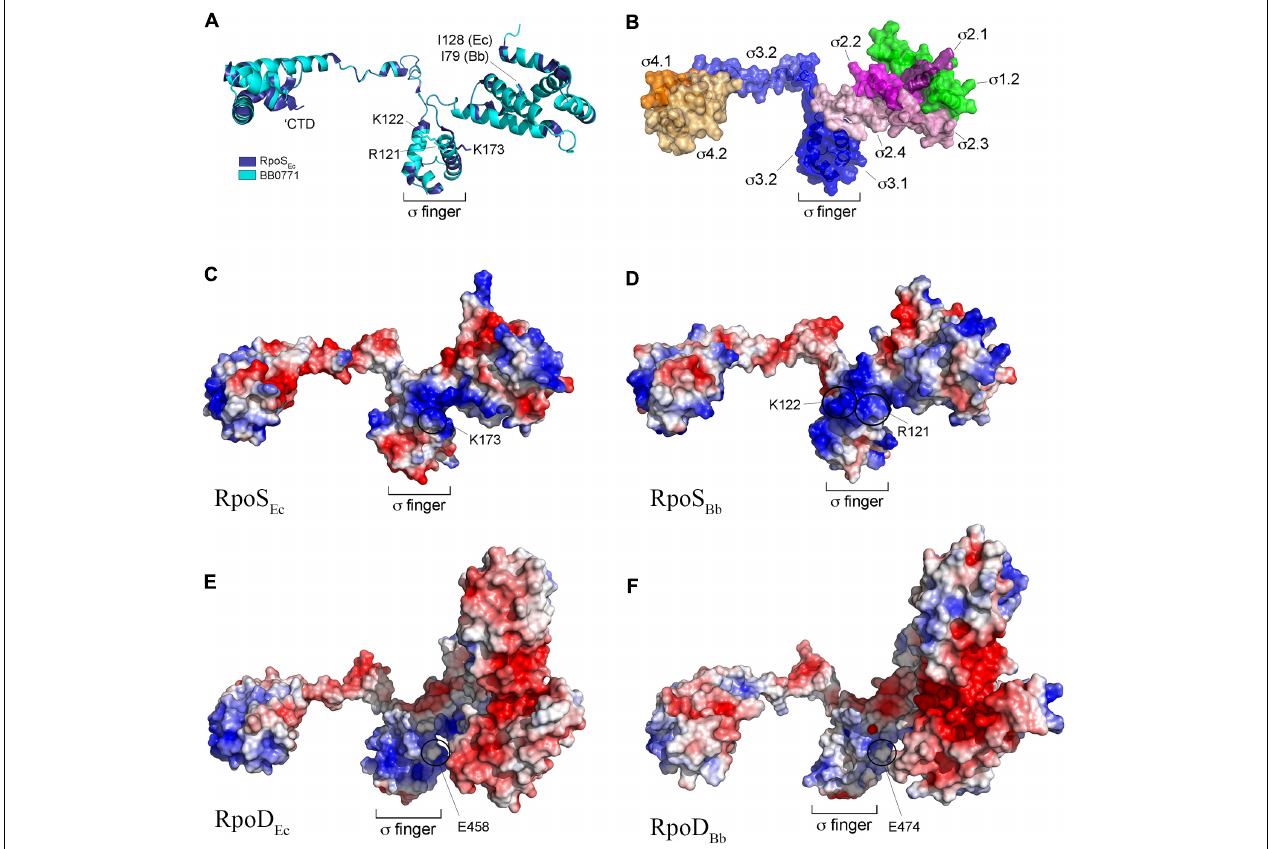
FIGURE 1 | RpoS Bb (BB0771) is a divergent RpoS that retains residues and structural features important for RpoS function and promoter selectivity. (A) Overlay of RpoS Ec structure (PDB: 5IPL-F) (Liu et al., 2016) and RpoS Bb homology model. Indicated are conserved isoleucine (I128 and I79 in RpoS Ec and RpoS Bb , respectively) (Iwase et al., 2017) and positively charged residues (K173 in RpoS Ec and R121 and K122 in RpoS Bb ) (Barne et al., 1997) known or predicted to be important for promoter selectivity by RpoS. The C-terminal domain (CTD, residues 315–330 in RpoS Ec ) conserved in RpoS homologs from γ -proteobacteria is indicated (Liu et al., 2016). (B) Functional subdomains in the RpoS Bb homology model were defined according to the corresponding regions in RpoS Ec (Lonetto et al., 1992) using the aligned structures in panel A . (C–F) Electrostatic distribution in RpoS Ec (C) , RpoS Bb homology model (D) , RpoD Ec (PDB: 6CY9) (E) , and RpoD Bb (BB0712) homology models (F) . The negatively charged glutamic acid residue (E458 in RpoD Ec and E474 in RpoD Bb ) in σ region 3.1 used to distinguish between RpoD ( σ 70 ) housekeeping and RpoS σ factors (Barne et al., 1997) is indicated.